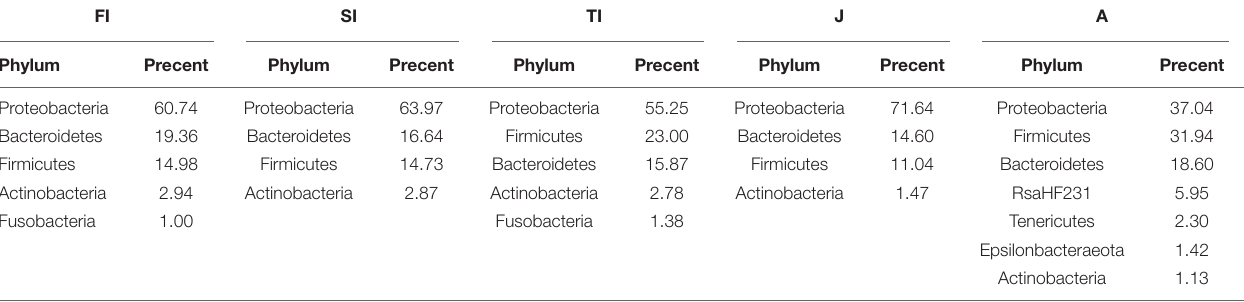
TABLE 1A | The relative abundance of gut abundant microbiota among the samples at the phylum level (A) and genus level (B). FI